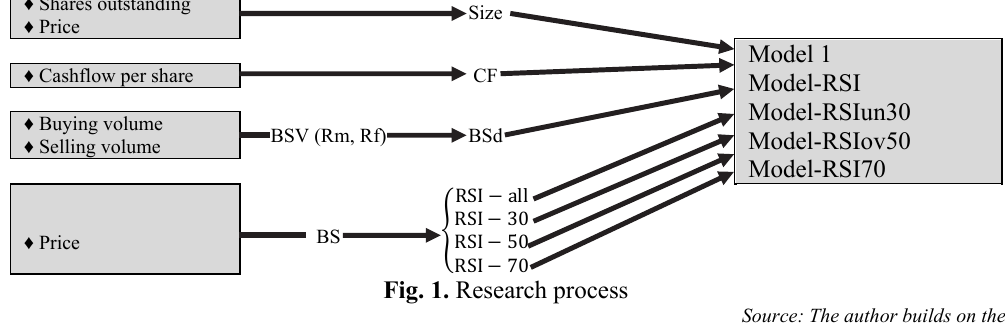
Fig. 1. Research process